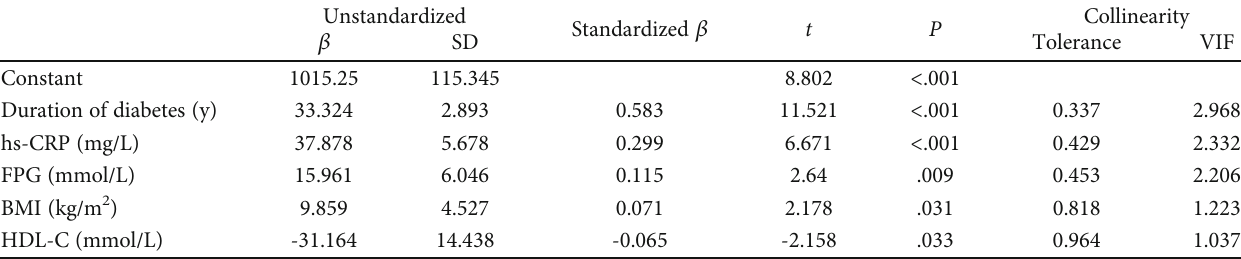
Table 3: Multivariate regression analysis for factors in fl uencing